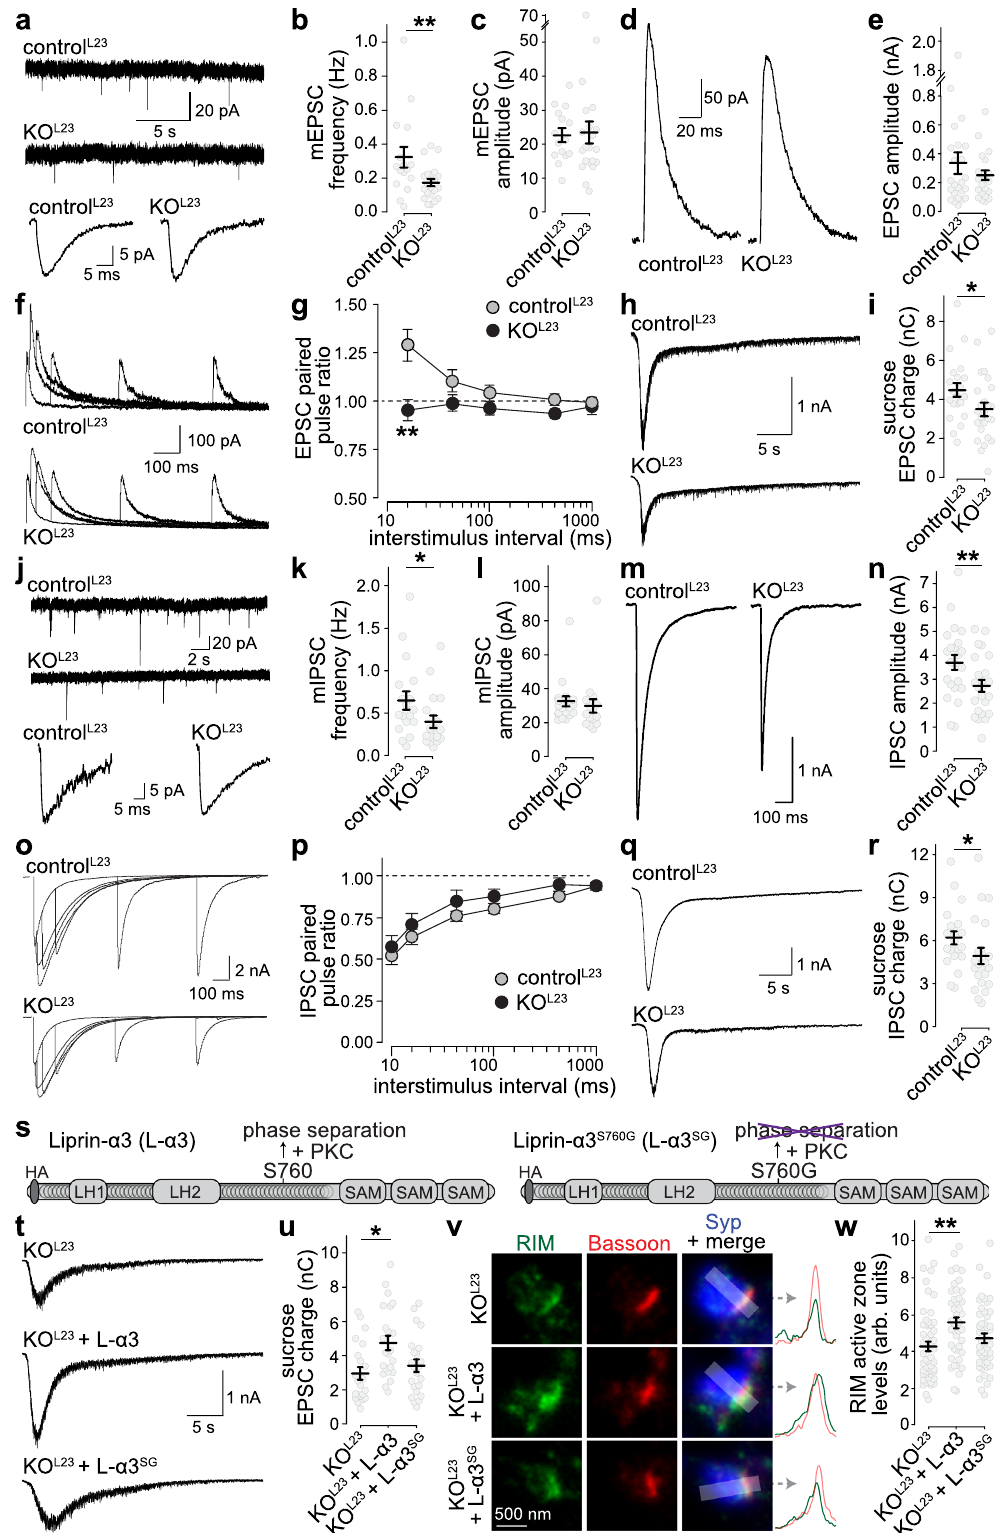
We fi nally investigated whether Liprin- α 3 phosphorylation and phase separation may control active zone structure. The lack of technology to selectively photobleach active zones within synapses with the necessary resolution of tens of nanometers prevents performing FRAP experiments to directly answer